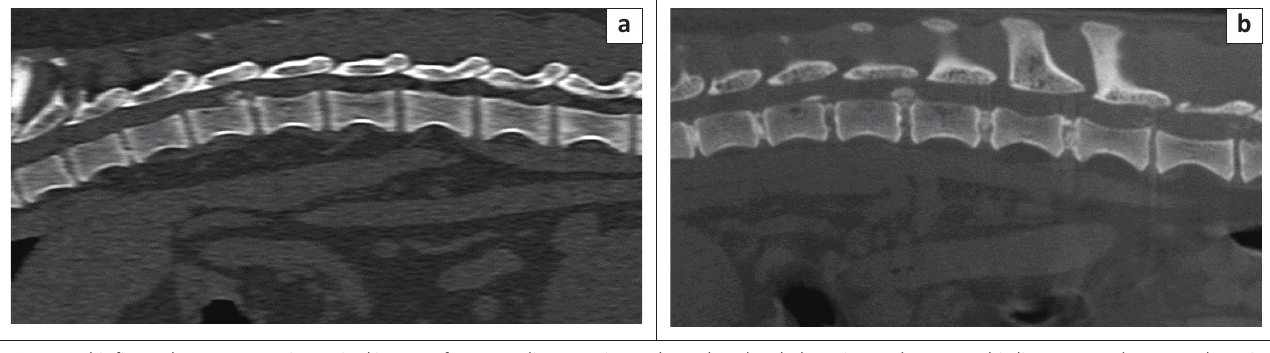
FIGURE 4: This figure shows comparative sagittal images of an acute disc extrusion at the 12th and 13th thoracic vertebrae on multi-slice computed tomography. Spine window (window width of 2000 and level of 500) (a) and high-definition volumetric computed tomography (b) in a bone window (window width of 1500 and level of